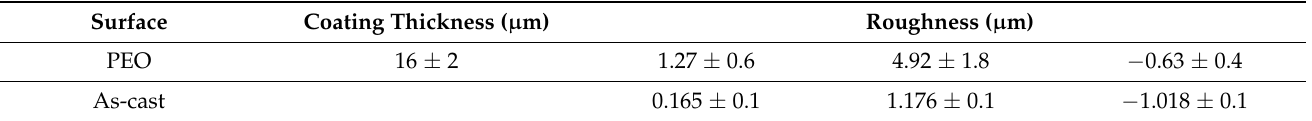
Table 2. Average thickness of PEO coating and roughness parameters of as-cast and PEO surface.